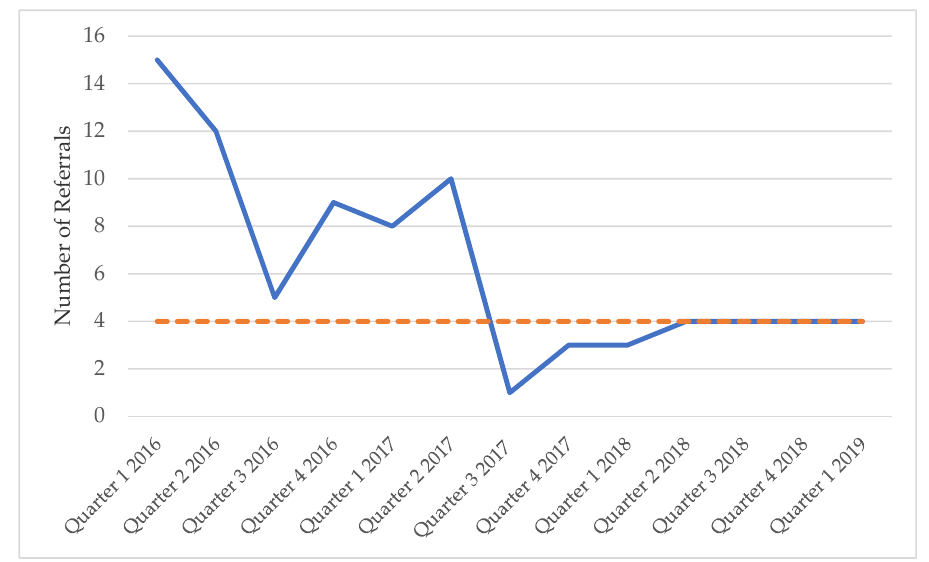
Figure 2. Number of referrals to the geriatric specialty clinic from the beginning of the project. The orange dotted line indicates the median.